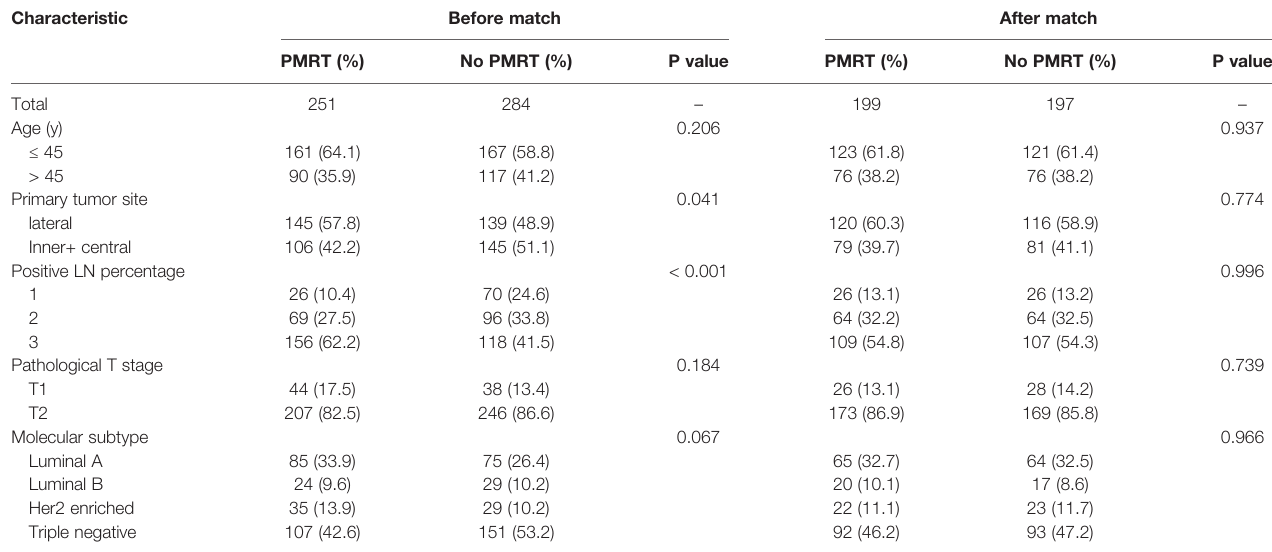
TABLE 6 | Clinical characteristics of high-risk patients with pT1-2N1M0 breast cancer before and after PSM 1:1 strati fi cation by treatment.